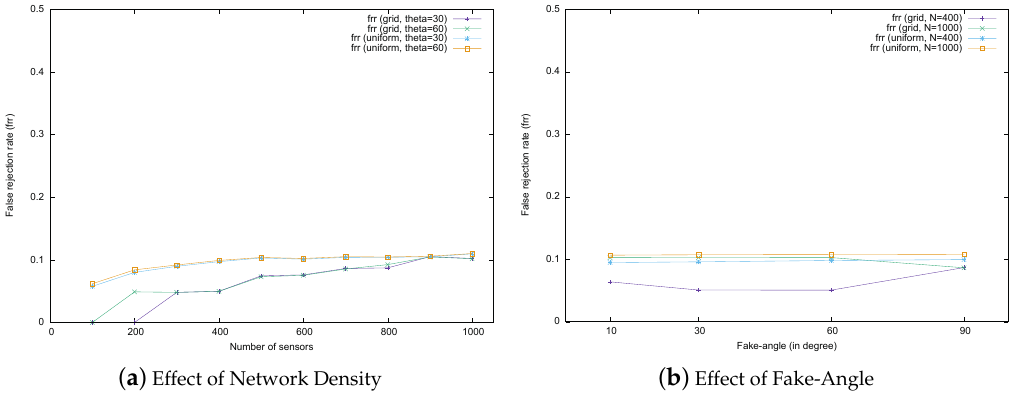
Figure 15. False rejection